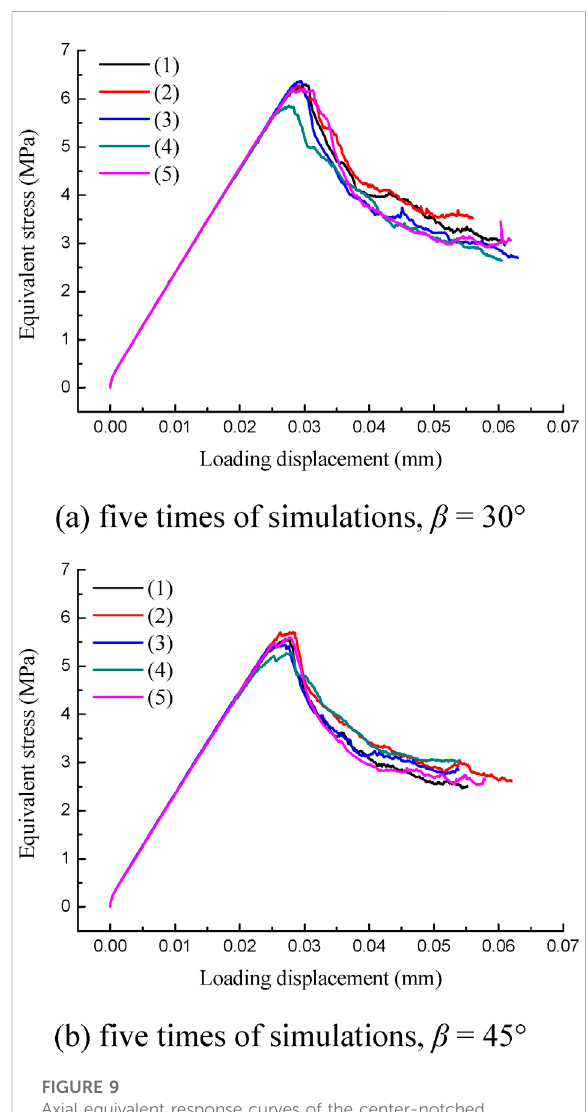
FIGURE 9 Axial equivalent response curves of the center-notched rectangular specimen with different β under the same heterogeneity degree ( m = 5).